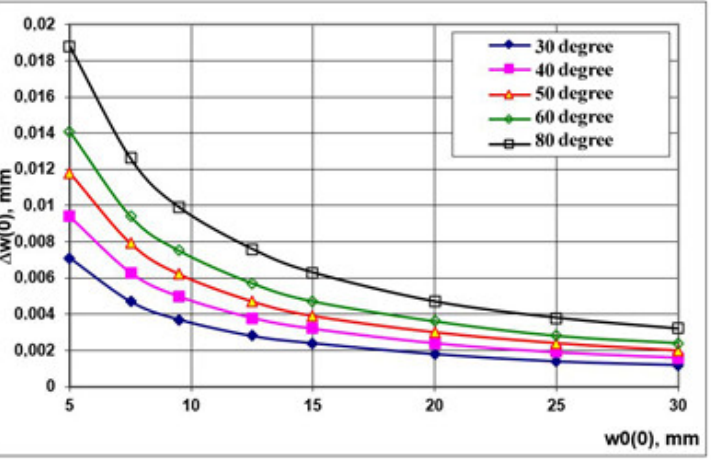
Figure 11. IS screen electrode additional deflection (∆w(0)) as a function of initially designed deflection (w 0 (0)) at different levels of temperature drop along SE radius.